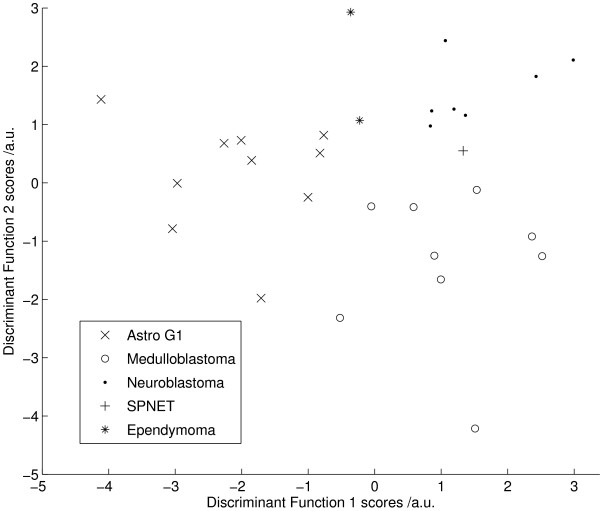
LDA Astro vs MB. Linear discriminant analysis of Astrocytoma G1 vs Medulloblastoma vs Neuroblastoma performed on the first 6 principal components of the fitted metabolite quantities. (classifier accuracy: 80%).